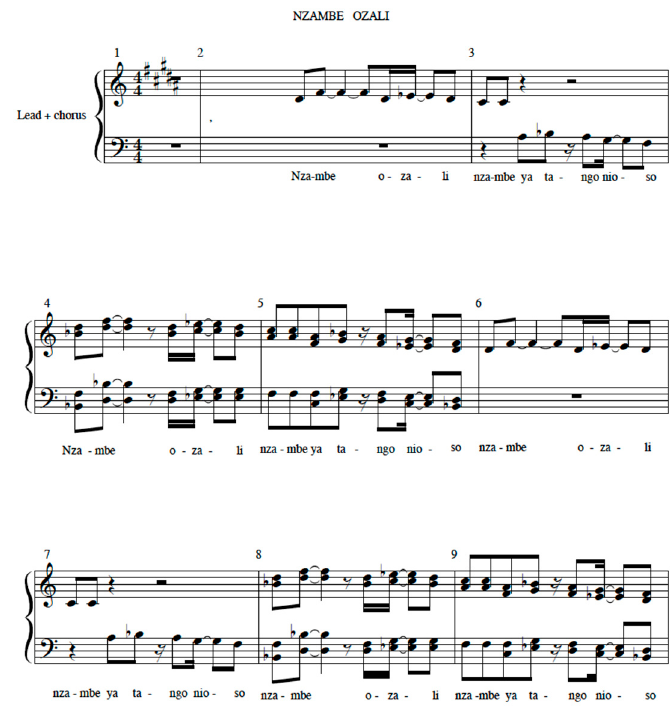
Figure 2. Excerpt of Music from Nzambe Ozali (trans. Hugo Mbunga).